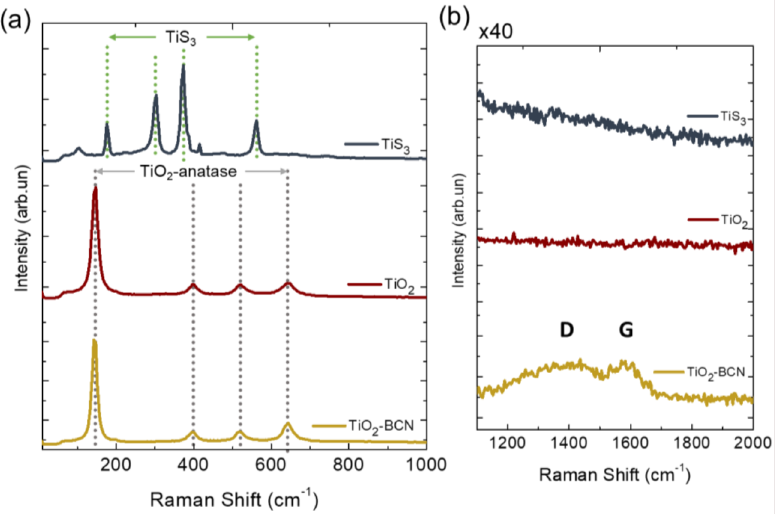
Figure 3. Raman spectra for TiS 3 , TiO 2 and TiO 2 -BCN samples in the ( a ) 100–1000 cm − 1 Raman shift range and ( b ) 1100–2000 cm − 1 Raman shift range with a × 40 zoom in the